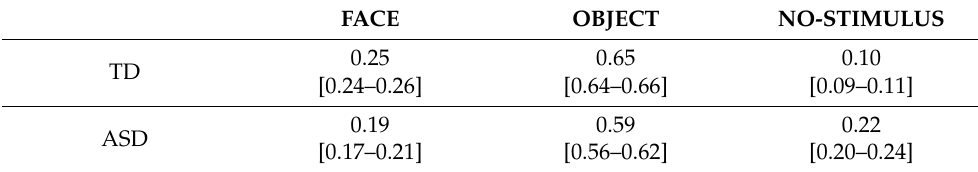
Table 3. Steady state of TD and ASD (CI:95% are reported between